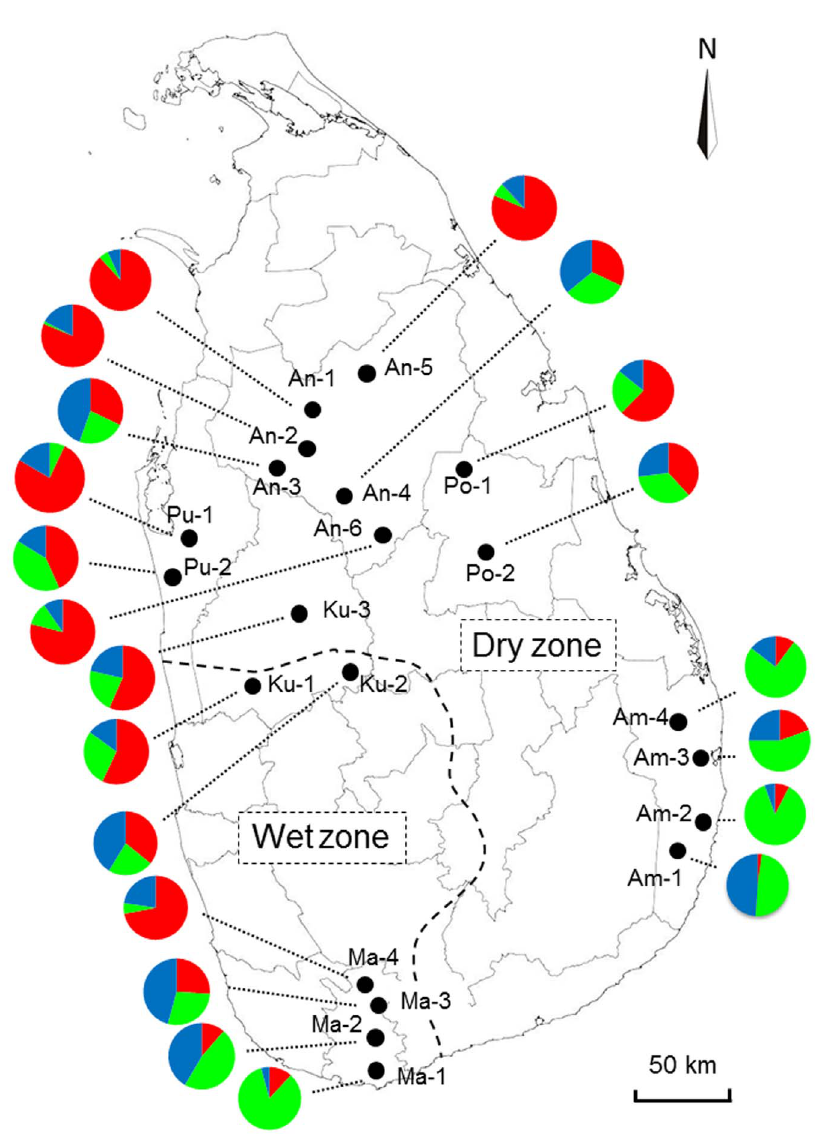
Figure 1. Geographical locations of the 21 weedy rice populations collected from Sri Lanka. The population codes at each collection site are shown in Table 1. Division of the Dry and Wet zones [9] is represented by the dotted line. The colors in pies are corresponded to those in the STRUCTURE analysis for weedy rice populations.